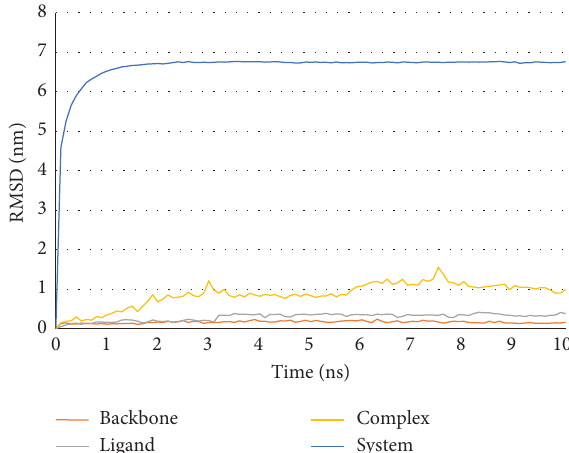
Figure 9: Boiled egg prediction of blood brain barrier permeability and gastrointestinal absorption for the 4 final drug candidates. Molecule 2 is a P-glycoprotein (P-gp) substrate, indicated by the blue dot, pointing out its ease of excretion from the body. Molecules 1, 3, and 4 are not P-glycoprotein (P-gp) substrates, exhibited by the red dots, signifying that they might not be easily excreted from the